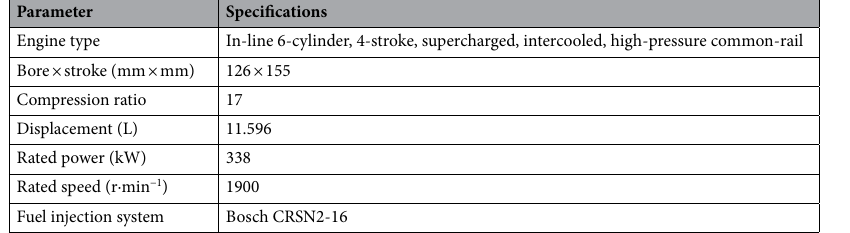
Table 1. Technical specifications of the diesel engine.